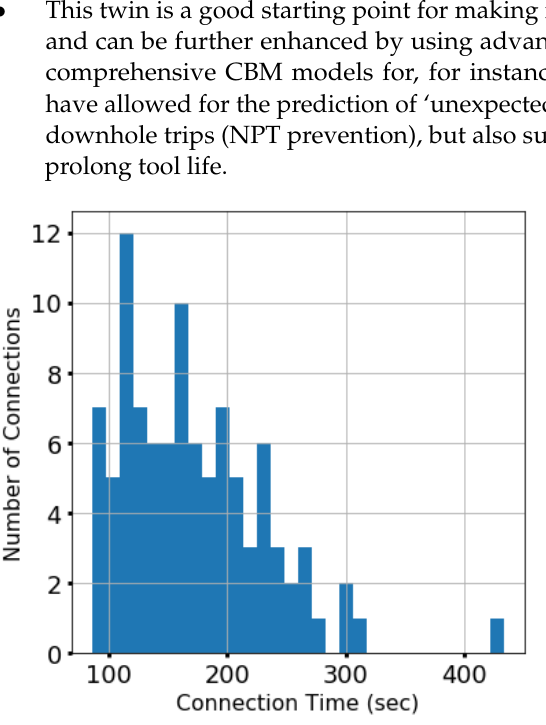
Figure 14. Variation and distribution of connection times for the drilling